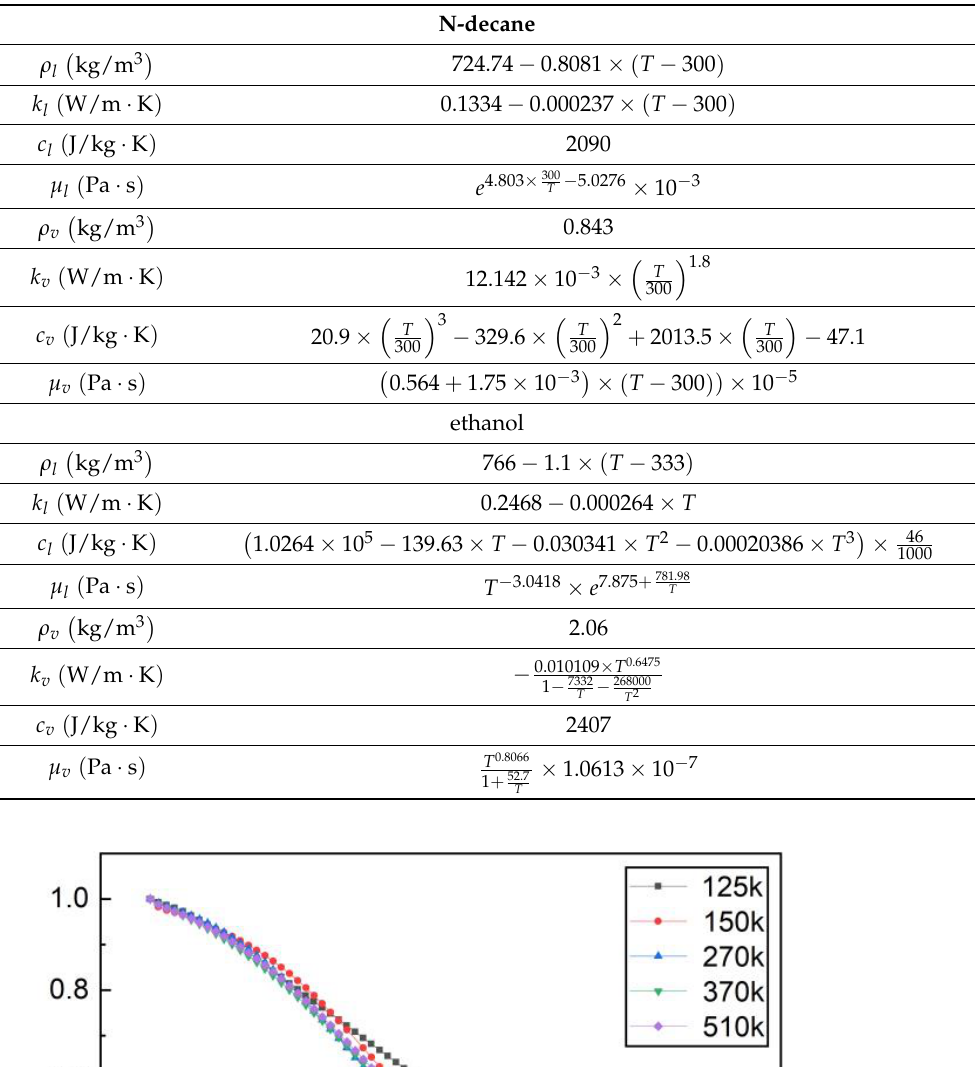
(Figure 2b). The evaporation rate constant K e can be obtained by the linear fitting of the experimental and calculated curves shown in Figure 2. Table 1. The physical properties of n-decane and ethanol.